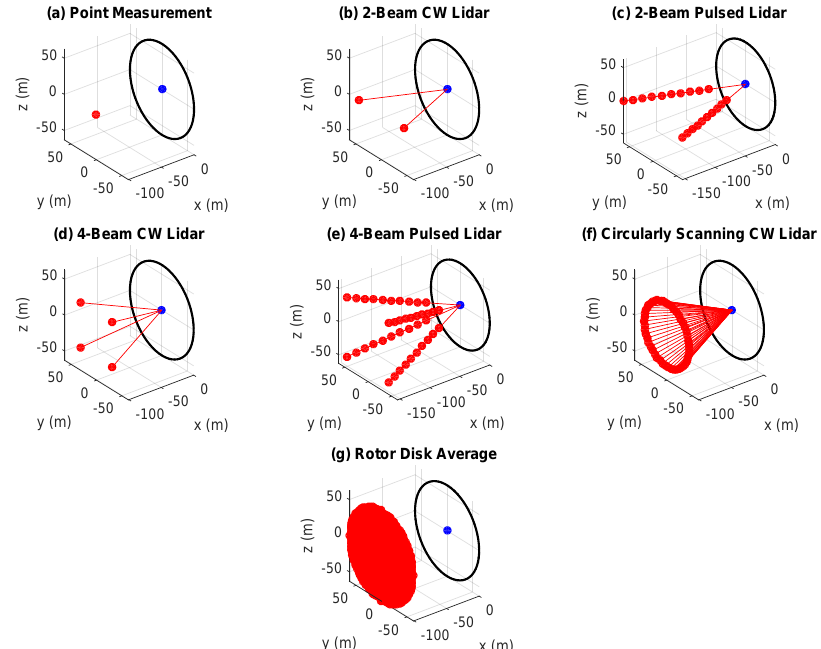
Figure 3. Lidar scan pattern scenarios investigated for scan pattern